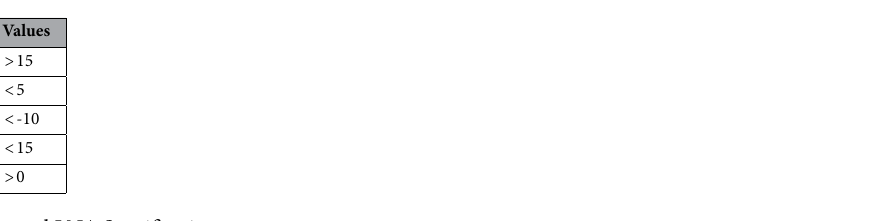
Table 1. The proposed LNA Specifications.